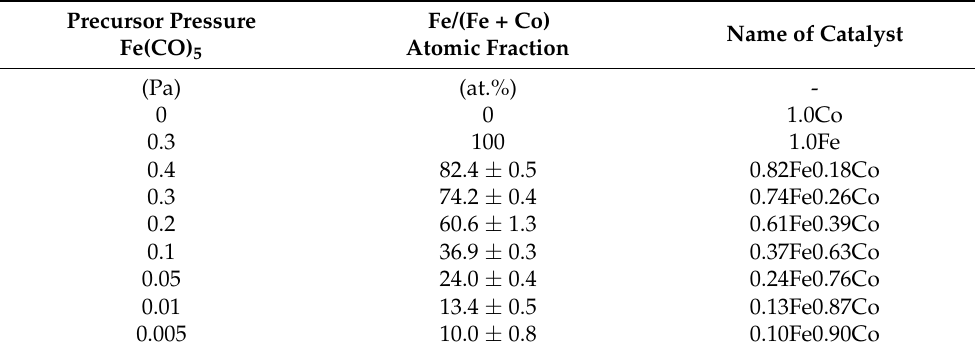
Table 1. The atomic fraction of iron and cobalt in the Fe–Co composites prepared by plasma at different pressures of iron precursor while keeping the pressure of cobalt precursor constant at 0.2 Pa. The composition is based on the EDX elemental